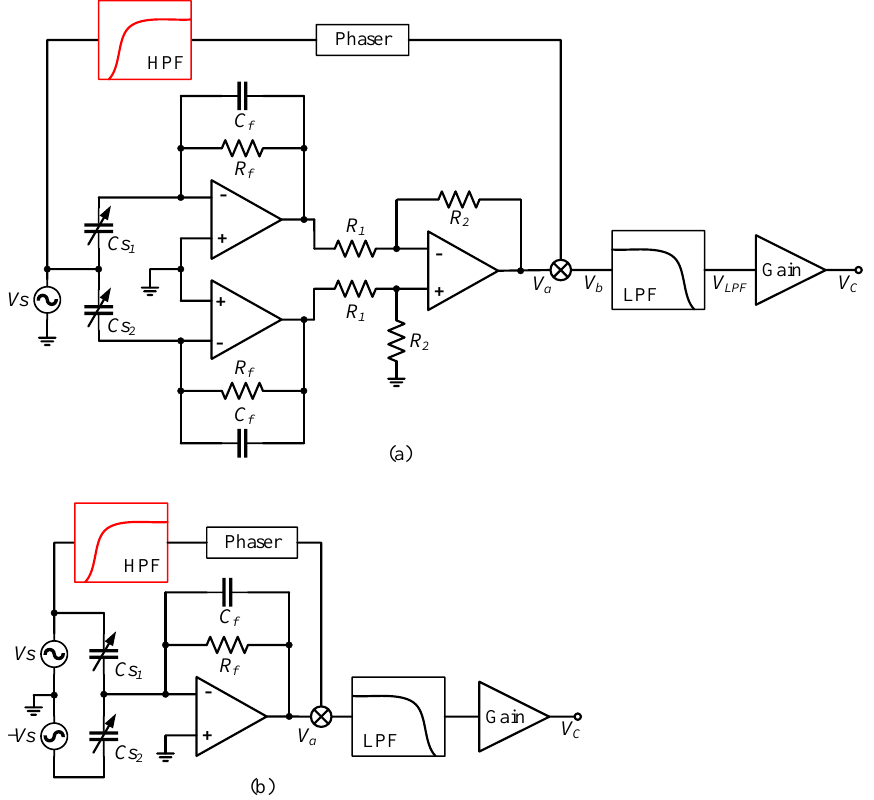
a high-pass filter in front of the phase-shifting circuit. The optimized carrier-modulated differential capacitance detection circuit is shown in Figure 14.